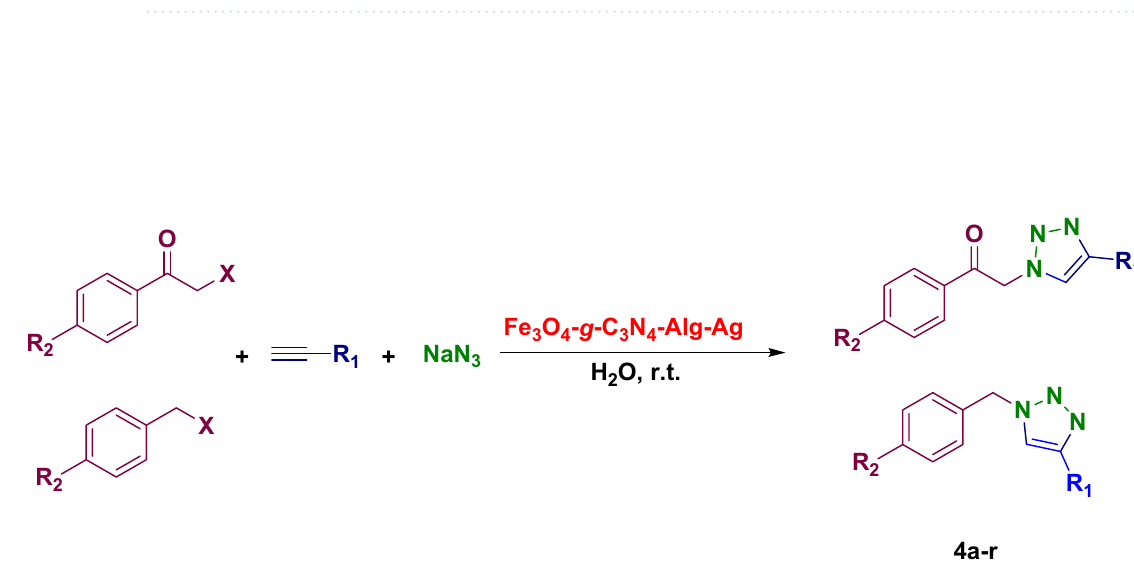
Figure 2. Synthesis of 1,4-disubstituted